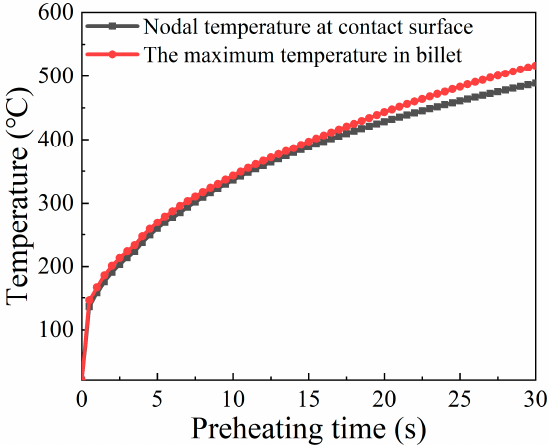
Figure 8. Evolution of the maximum temperature and the nodal temperature of contact surface over time during the preheating stage.